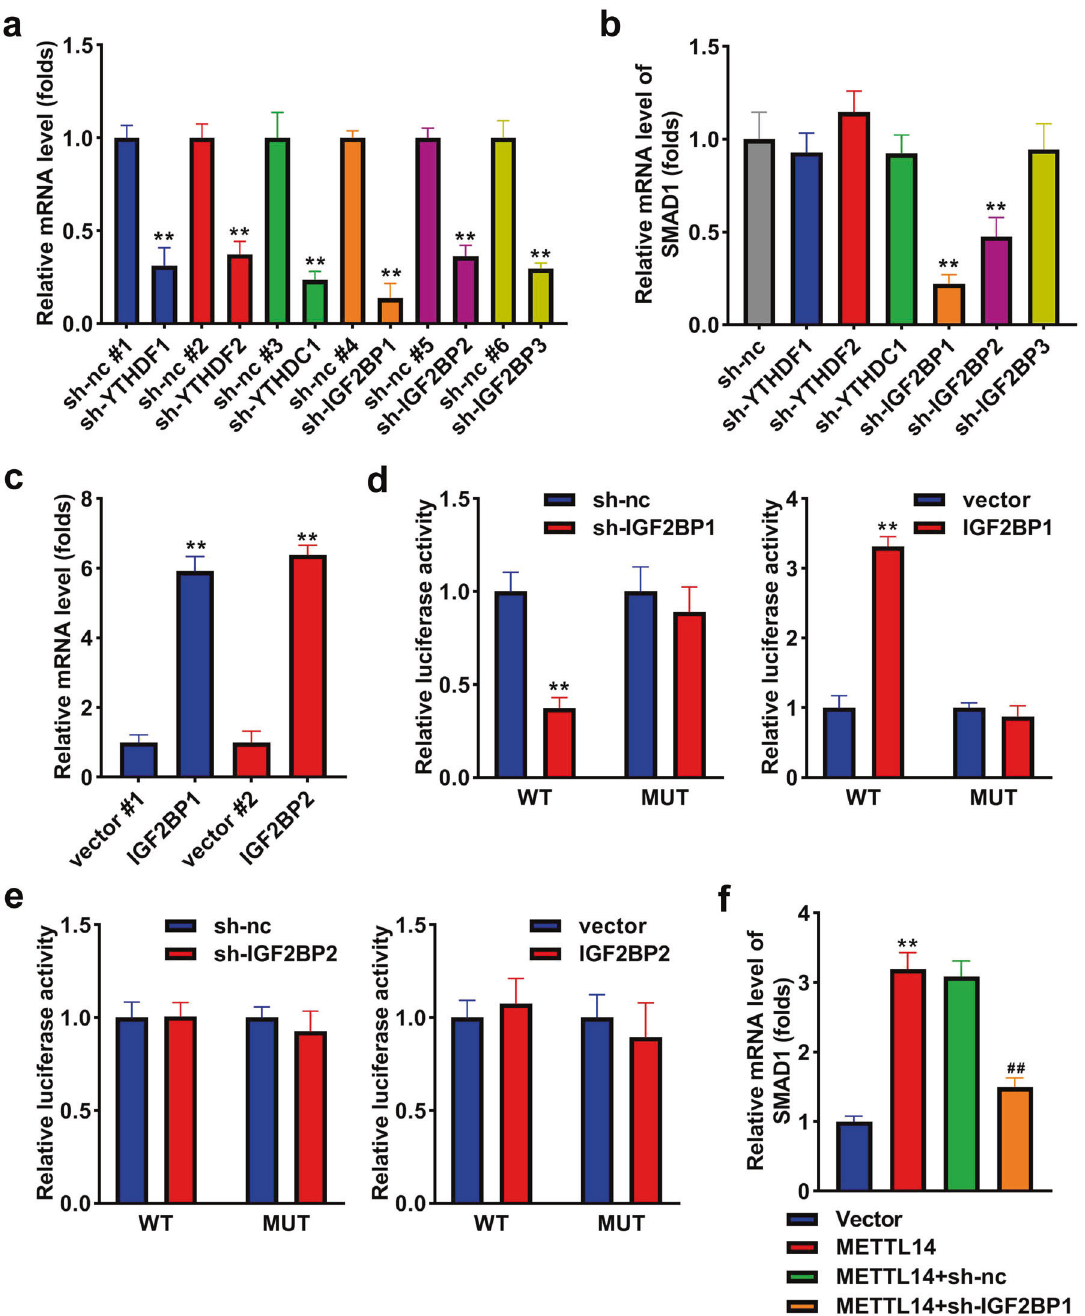
Fig. 7 IGF2BP1 is positively related to SMAD1. a The levels of YTHDF1, YTHDF2, YTHDC1, IGF2BP1, IGF2BP2, and IGF2BP3 after transfection. b qRT-PCR measured SMAD1 after the knockdown of YTHDF1, YTHDF2, YTHDC1, IGF2BP1, IGF2BP2, and IGF2BP3. c IGF2BP1 and IGF2BP2 levels after transfection. d The relationship between IGF2BP1 and SMAD1 was assessed by luciferase reporter assay. e The relationship between IGF2BP2 and SMAD1 was assessed by luciferase reporter assay. f SMAD1 expression was measured after overexpression of METTL14 and knockdown of IGF2BP1. ** P < 0.01. ## P < 0.01 vs. sh-METTL14 +